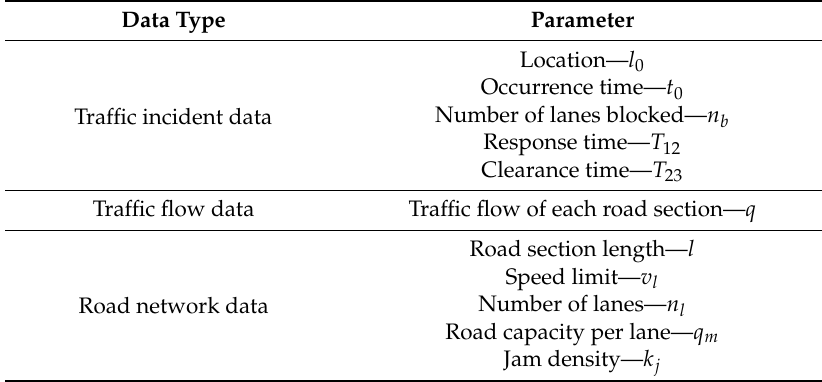
Table 1. Inputs to the spatiotemporal influence prediction model from the traffic incident.